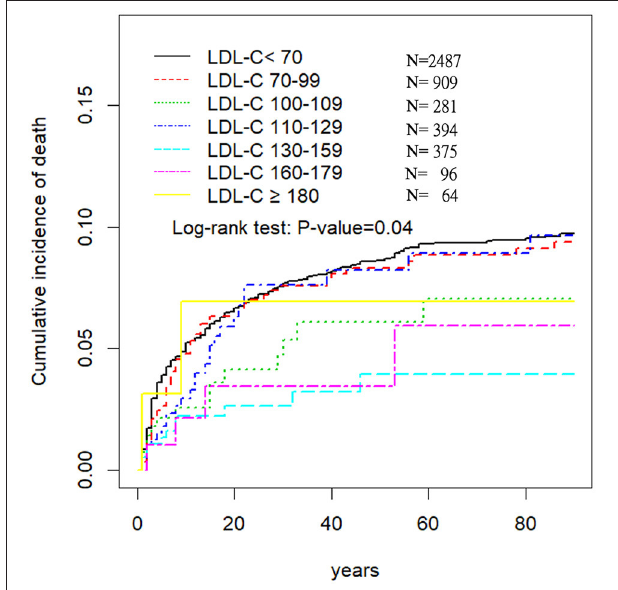
FIGURE 2 | Three-month survival in different LDL-C groups in 4,066 ICH patients.